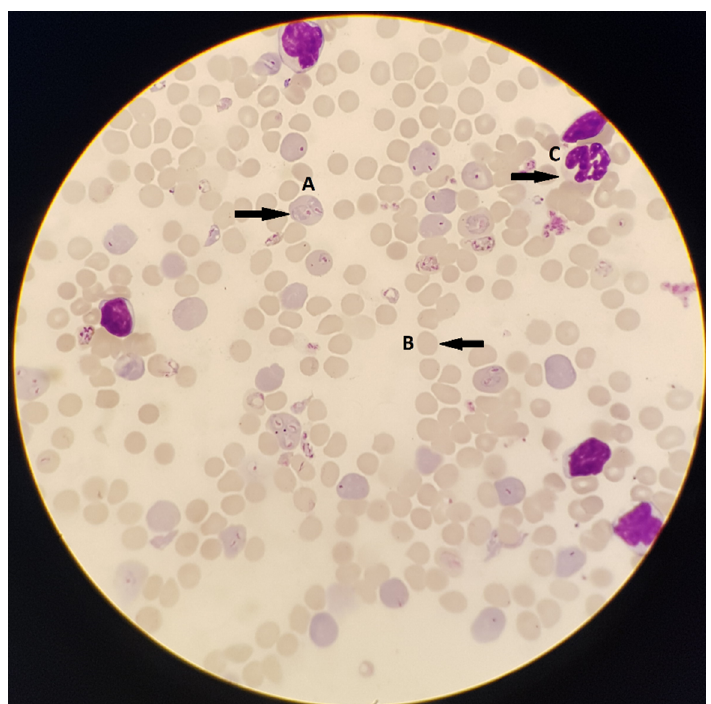
Figure 2. Microscopy of a thin smear P. falciparum infected erythrocytes stained with Giemsa. ( A ) A red blood cell infected with two malaria parasites in the “ring” stage as seen under a microscope at 100 × oil immersion. ( B ) A normal uninfected red blood cell. ( C ) A normal leukocyte.